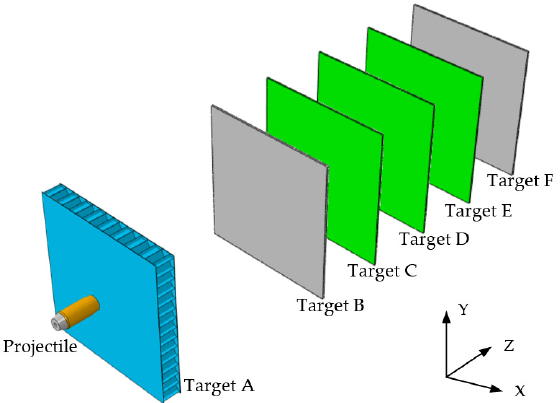
Figure 4. Visualization of the finite element simulation model.